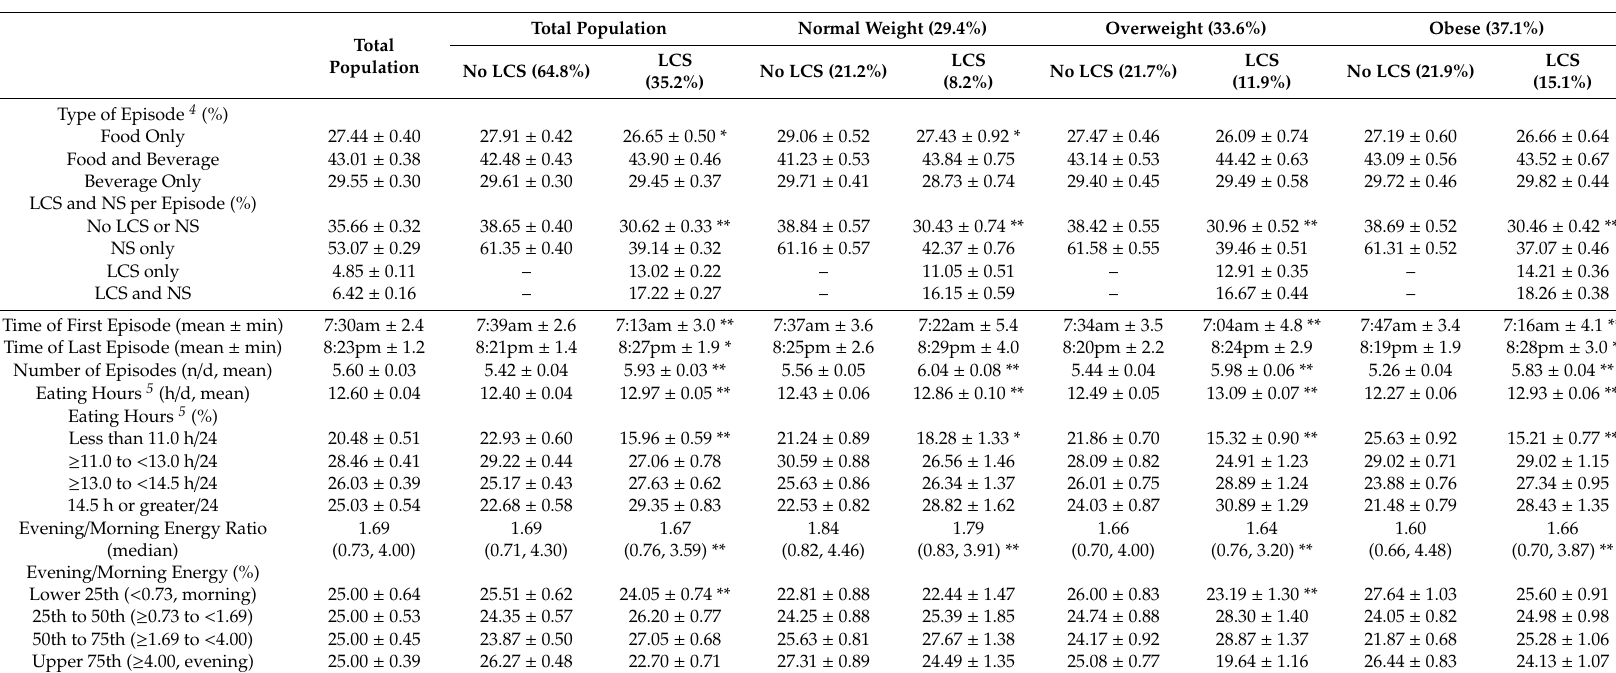
Table 1. Eating episode level 1 and person level 2 ingestion characteristics (i.e., mean or percent ± standard error; median (25th, 75th percentile) across the day in